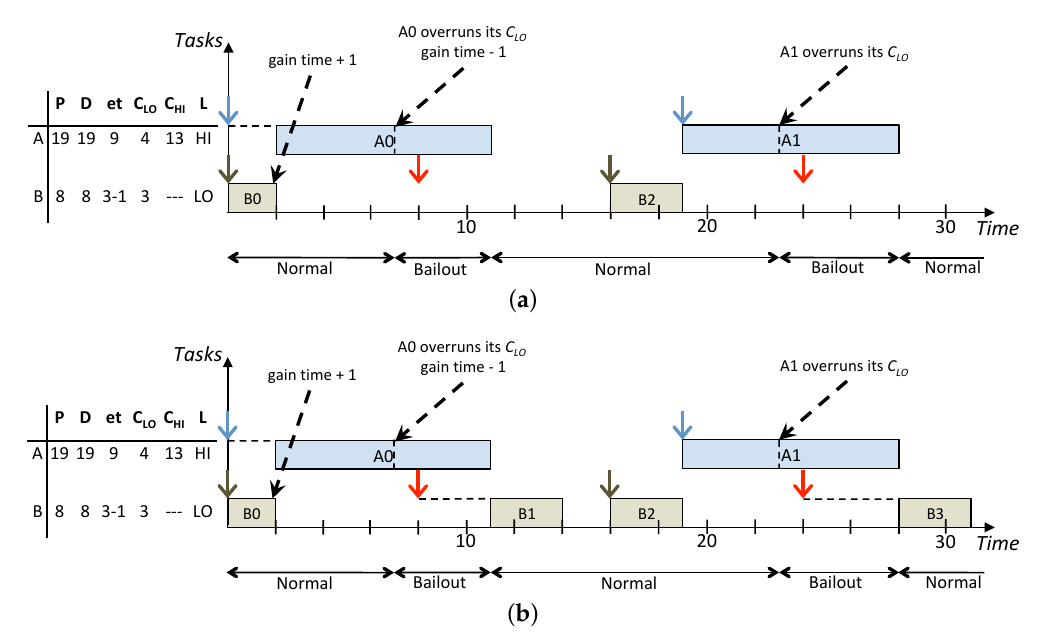
Figure 5. (Proof of Theorem 4) Example in which LBPG successfully executes LO jobs that are abandoned by BPG: ( a ) BPG abandons LO jobs in Bailout mode; and ( b ) LBPG provides a